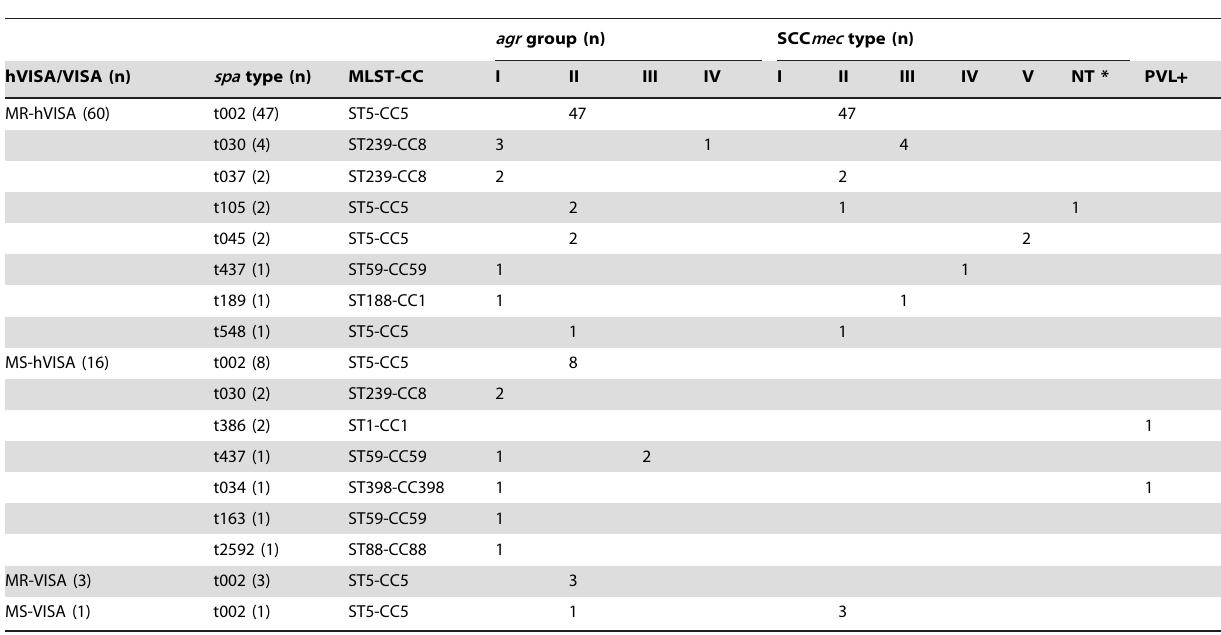
Table 4. Molecular characteristics of all hVISA and VISA isolates.